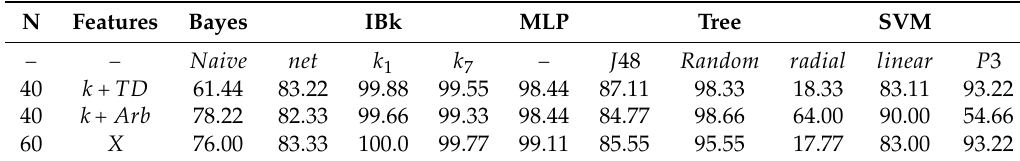
Table 5. Classification performance of the combined